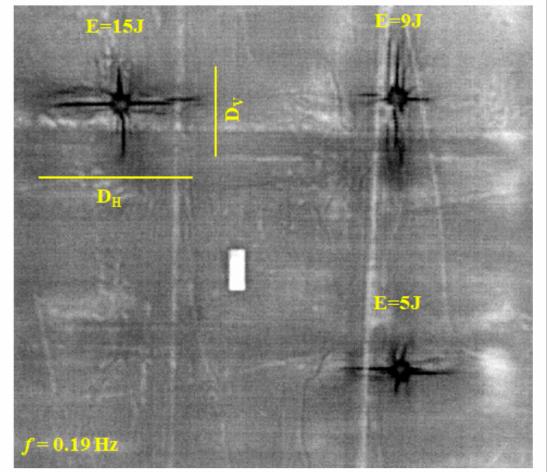
Figure 10. Indication of D H and D V over a phase